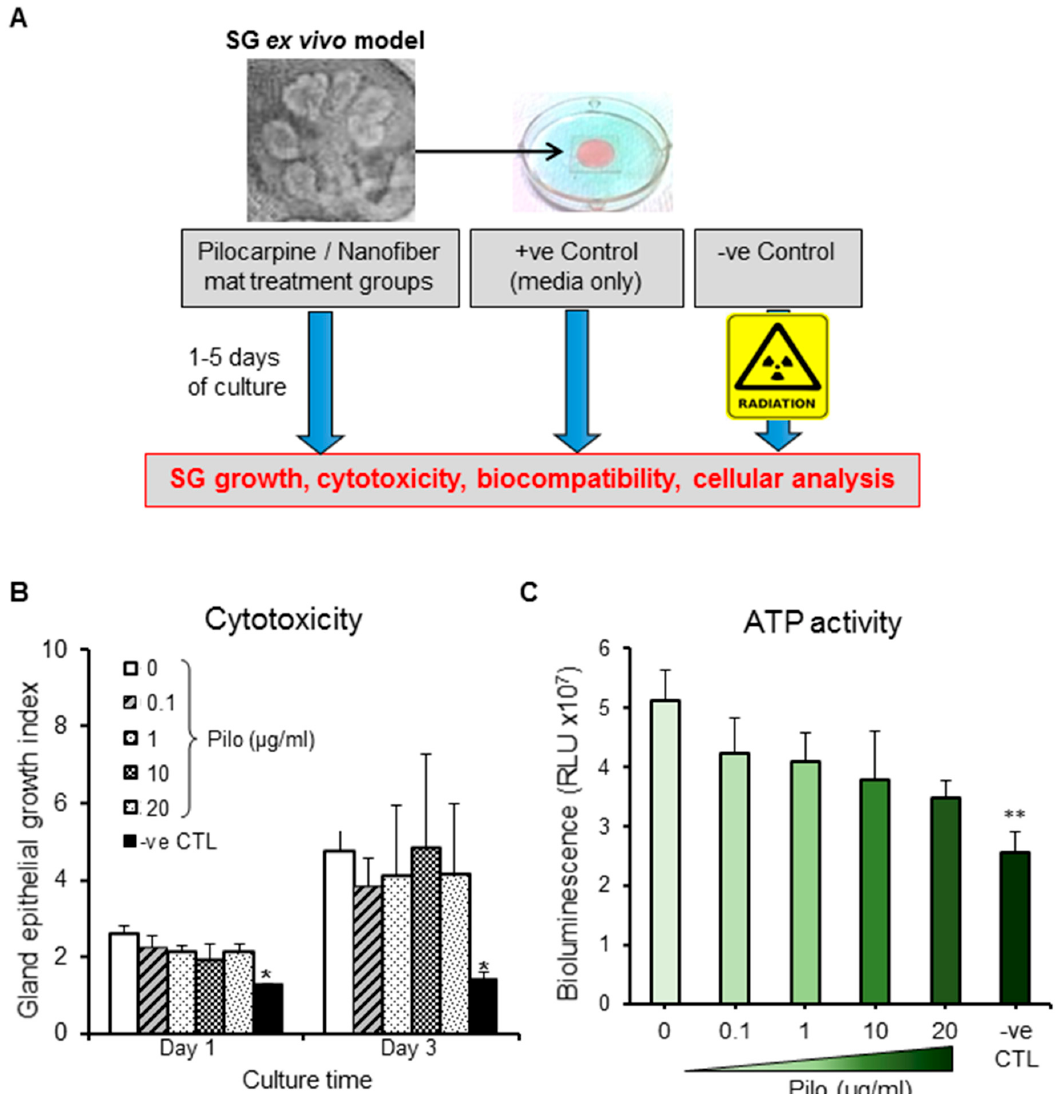
Figure 2. Biological effects in an ex vivo SG model. ( A ) Ex vivo SG model experimental set up used for testing the cytotoxicity of pilocarpine and biocompatibility of different nanofiber mats. ( B )